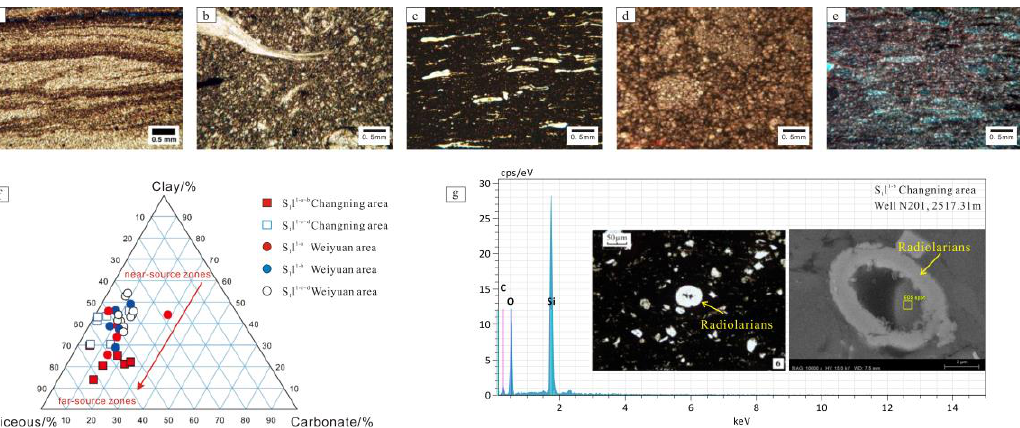
Figure 11. Characteristics of shale siliceous components. ( a ). Silty shale; ( b ). Plant detrital mudstone; ( c ). Clay shale; ( d ). Dolomitic shale; ( e ). Siliceous shale; ( f ). Ternary diagram of the mineralogy of shale; ( g ). Characteristics of siliceous components in shale.